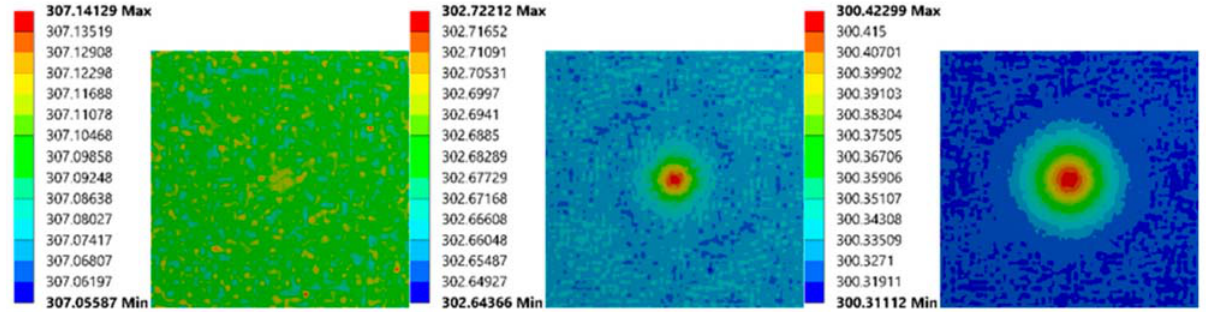
Figure 15. Simulation images of FEA model (5.95 mm diameter, 4.76 mm depth) at 33 s, 60 s, 150 s (from left to